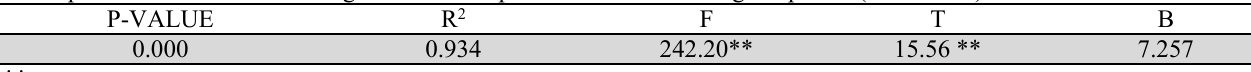
B T F 2 R P-VALUE